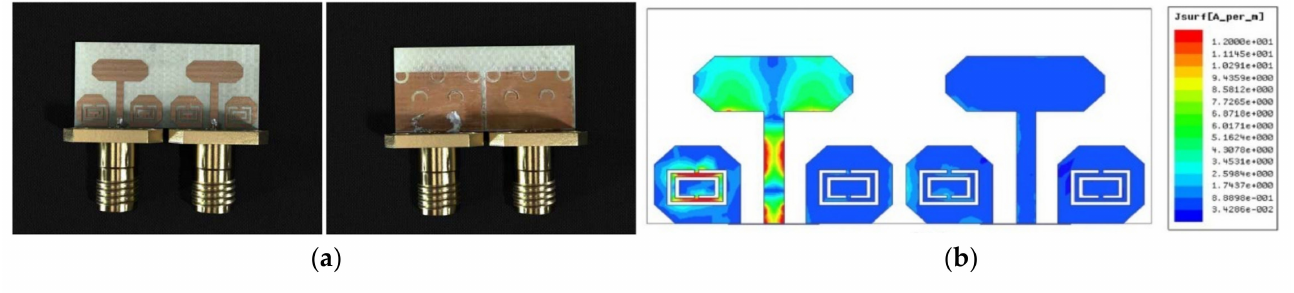
Figure 3. MIMO antenna with DGS and CSRR: ( a ) geometry of proposed MIMO; and ( b ) the current distributions with hybrid decoupling structures (Results from